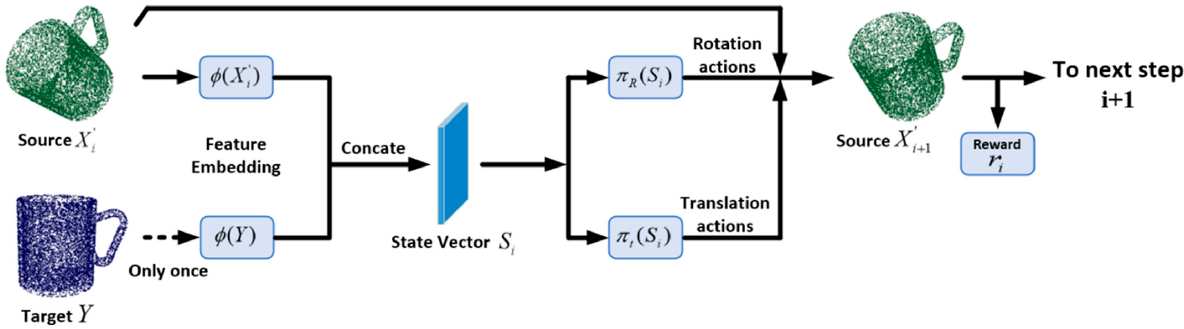
Figure 1. Architecture of ReAgent for one step.